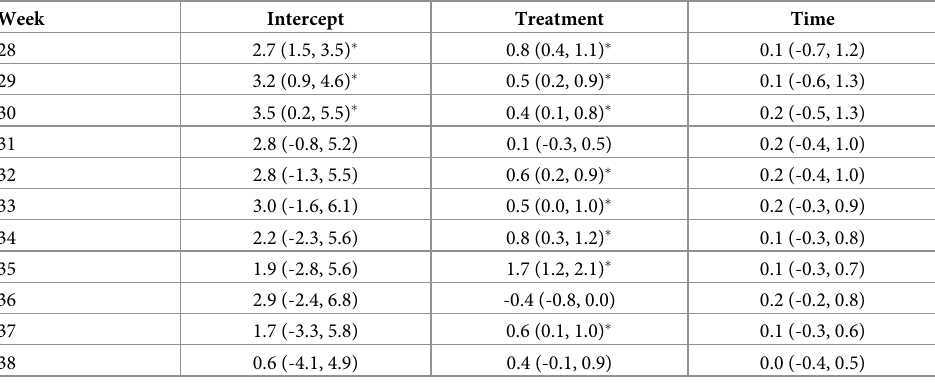
� value is statistically different from zero with a 95% probability; the expected value is the 50 th percentile of the parameter’s posterior distribution, the CIs were drawn using the 2.5 th and 97.5 th percentiles of the parameter’s posterior distribution.